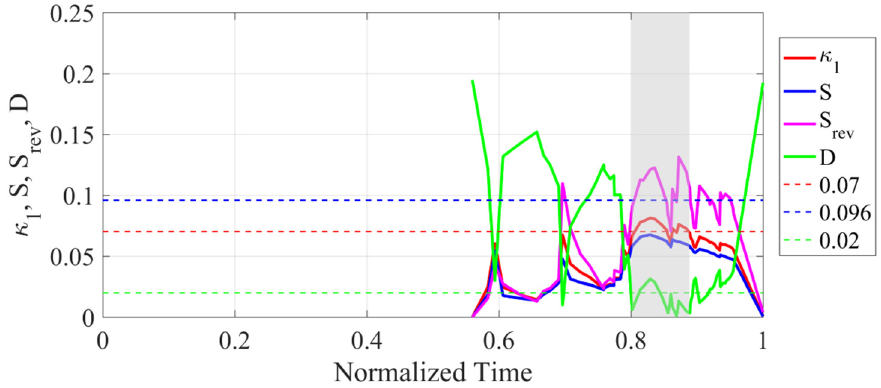
Figure 14. Natural time analysis versus the normalized time for AE activity registered in the LDEM.